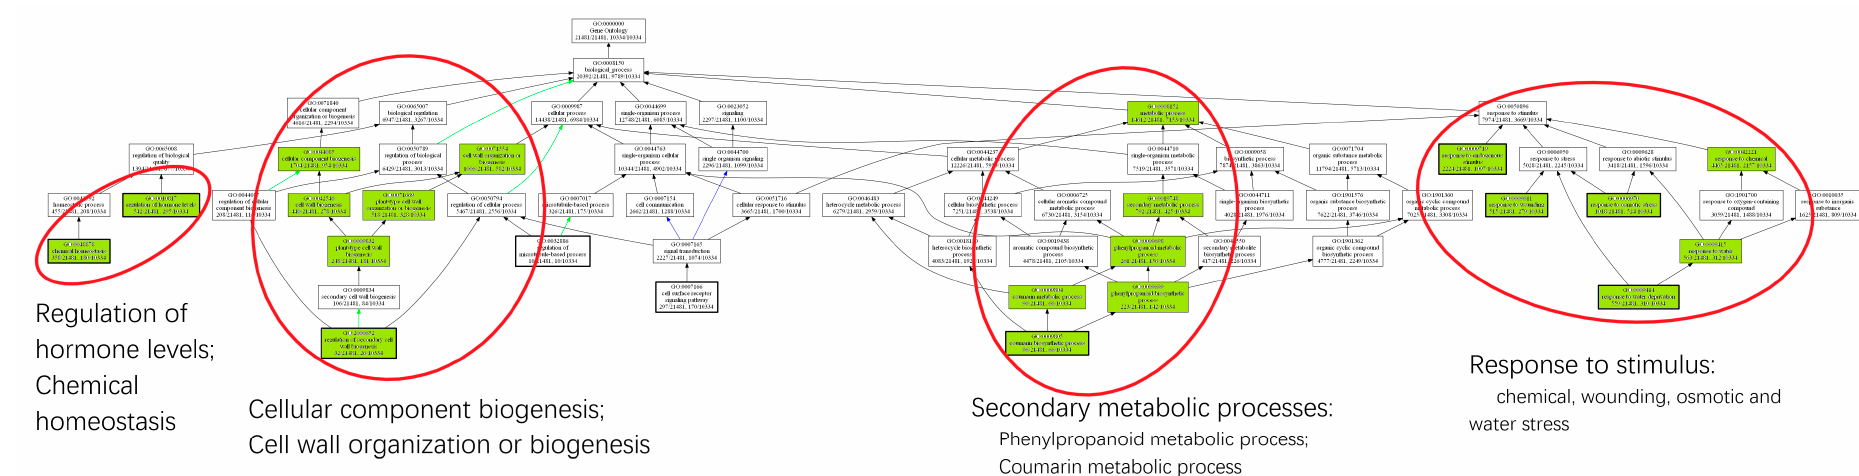
Figure 4. Hierarchy of enriched GO-terms in wood of poplar (hybrid T89) in response to severe drought. DEGs were used to determine significant GO terms. Enriched GO terms ( p adj < 0.05) are colored in green and GO terms not enriched are shown in white. Some GO terms were omitted in this figure. Further details are shown in Supplement Figure